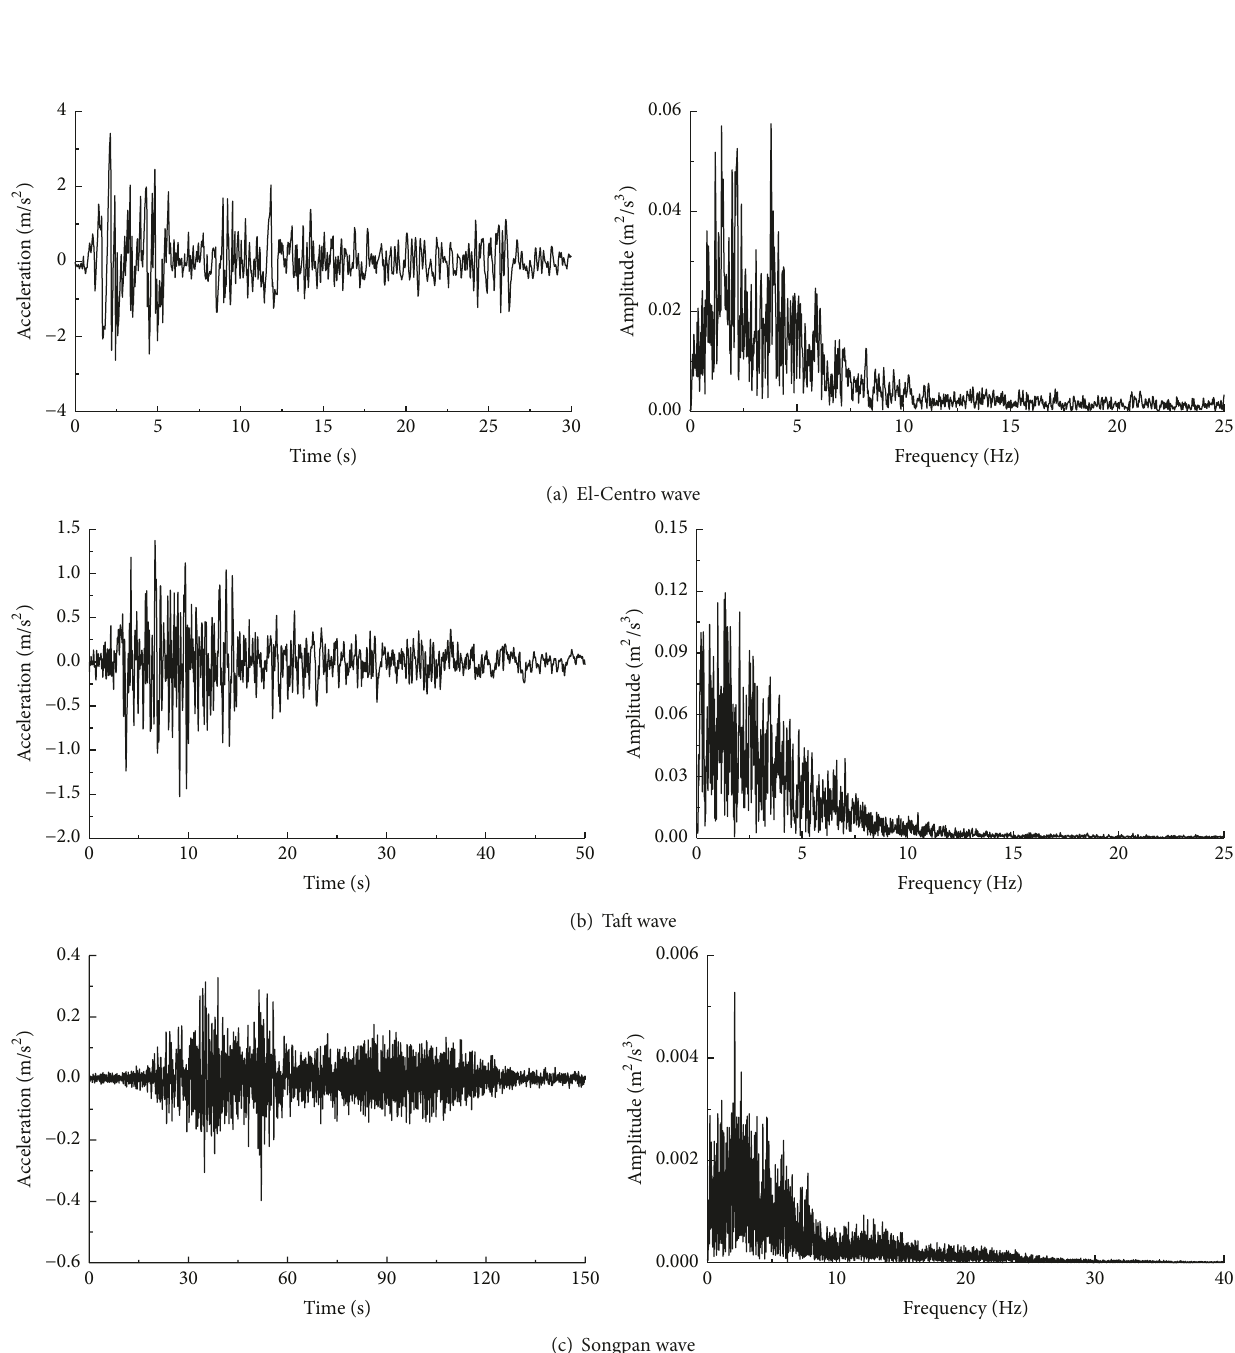
Figure 7: Time history and Fourier spectrum curves of input